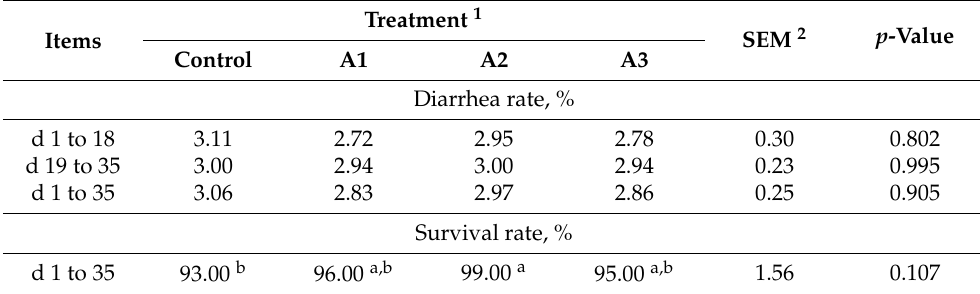
Table 2. Effects of acidifiers on the diarrhea and survival rate of weaned